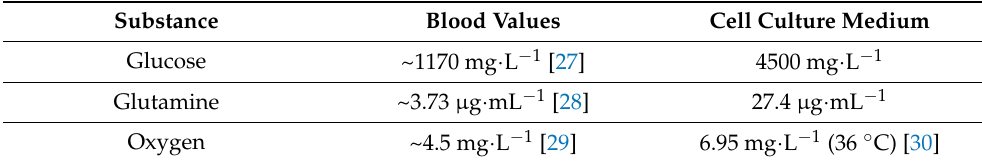
Table 1. Summary of initial concentrations of essential nutrients for cells in blood and cell culture medium, with